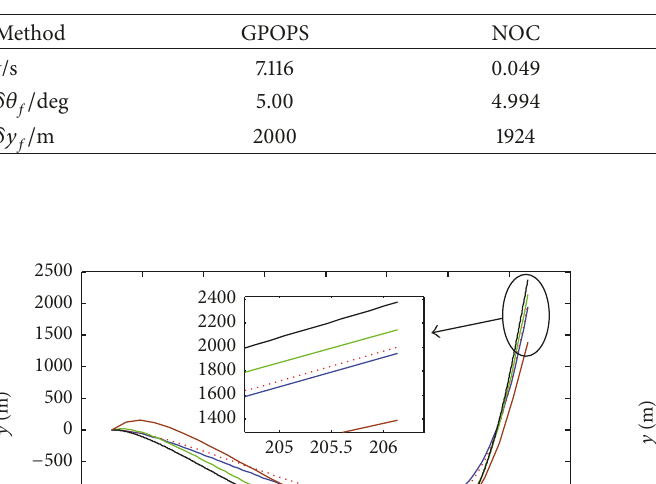
Table 2: Comparison of time consumption terminal modification.